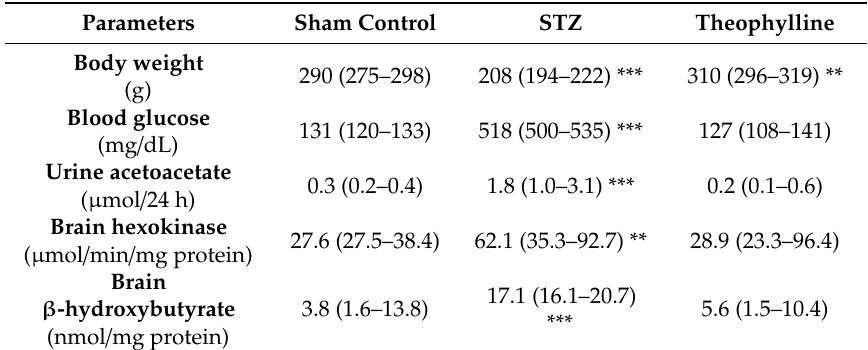
Table 1. List of primers and TaqMan probes used in this